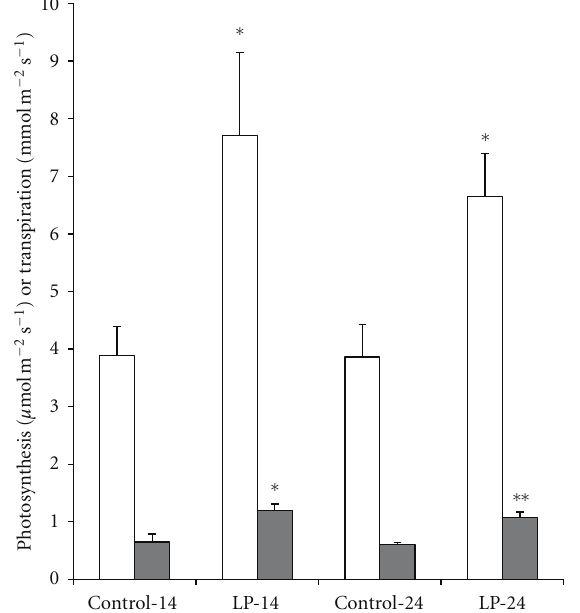
Figure 1: Leaf photosynthetic rate and transpiration rate in soybean plants grown with original pots (Control) and with larger pots (LP). Half of plants with age of 40 days were grown with larger pots for 14 (Control-14 or LP-14) or 24 days (Control-24 or LP-24). Open bar, photosynthetic rate; closed bar, transpiration rate. Vertical bars, S.D. ( n = 3). ∗ P < 0 . 05/ ∗∗ P < 0 . 01 ( t -test) when compared with control.